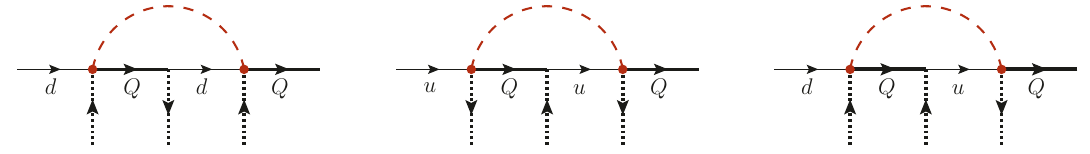
Figure 4 . Representative one-loop Feynman diagrams with ALP exchange (red dashed line), which require operators in the class ψ 2 H 3 as counterterms. Graphs involving both e Y the third one, vanish after summing over the permutations of the Higgs